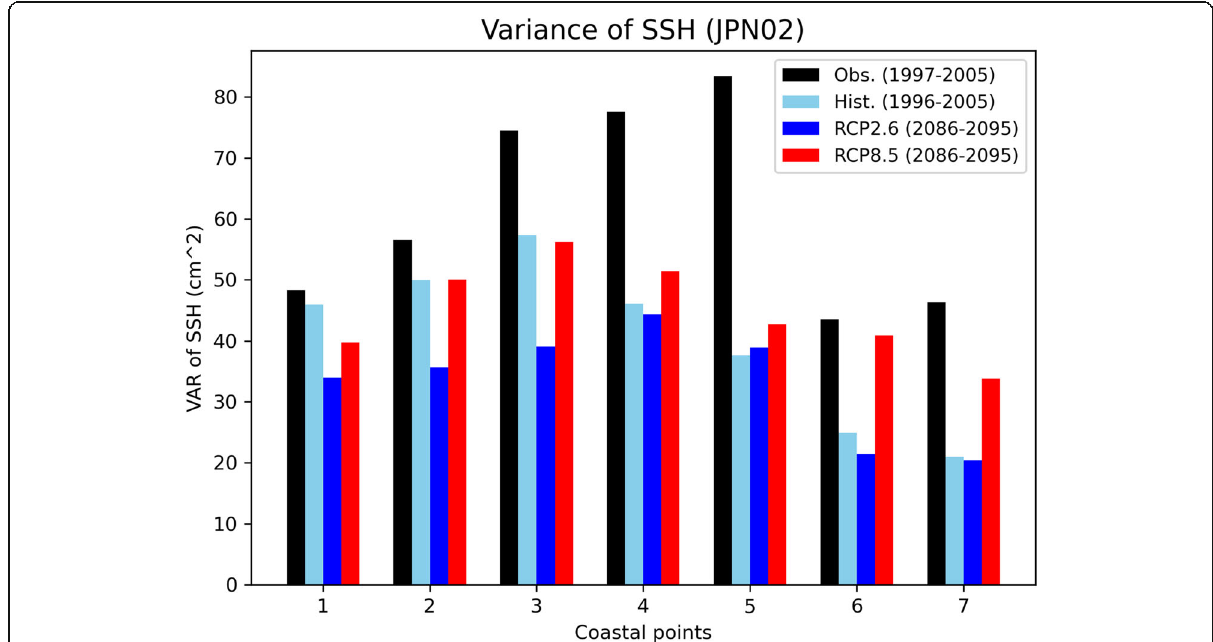
Fig. 14 SSH variance (cm 2 ) at seven coastal points along the southern coast of Japan shown in Fig. 12 comparing the historical (1996 – 2005), RCP2.6 (2086 – 2095), and RCP8.5 (2086 – 2095) cases from the MRI-CGCM3 forced results of the JPN02 and the JMA observation (1997 –